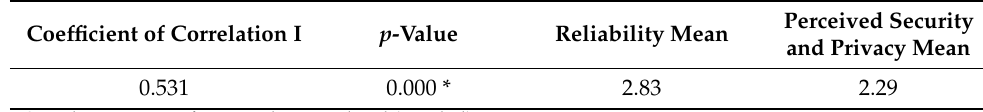
Table 8. Correlation between reliability and perceived security and privacy.